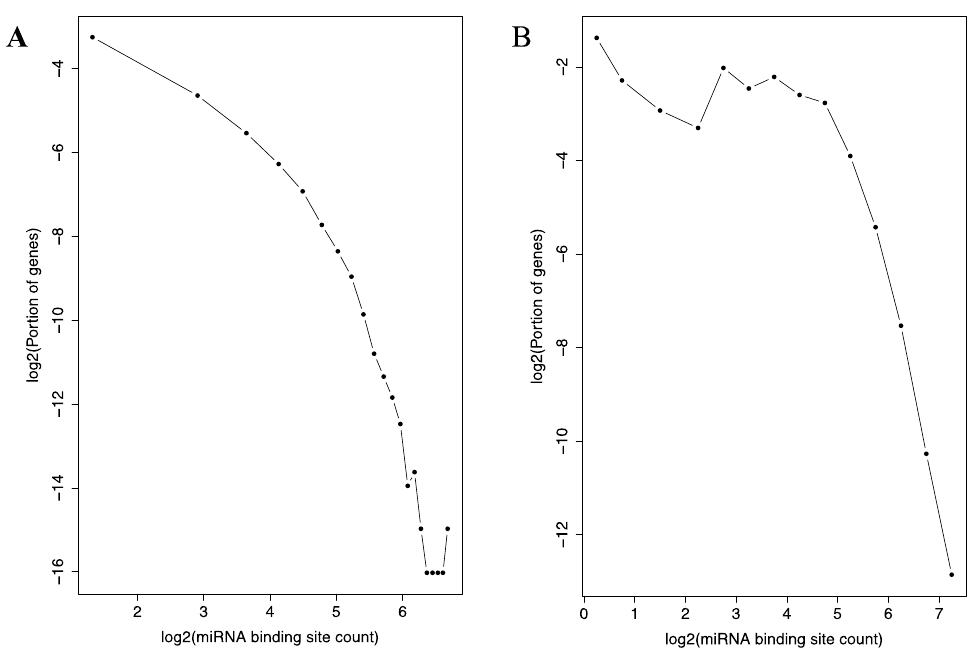
Figure 5. Histogram of miRNA binding site distribution across the genes. Log-log plots of the histograms are shown for the TargetScan ( A ) and the miRTarBase ( B ) datasets. The curve in A depicts a negative correlation that resembles previously described log-log histograms of many types of scale-free networks [36]. The same is observed in B at high connectivity range.